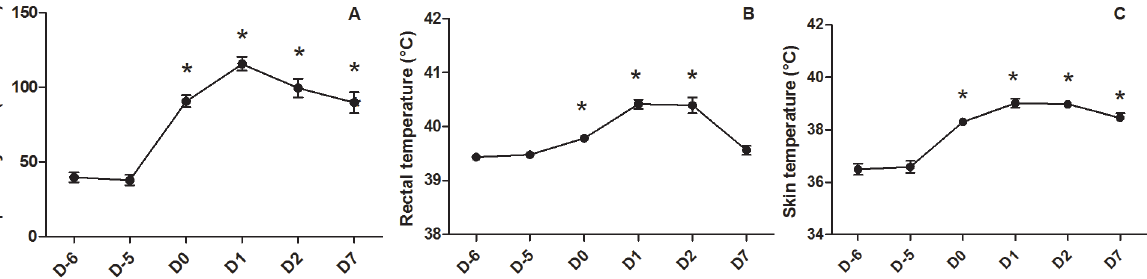
Figure 2. Effect of exposure to 32 6 C on physiological parameters in growing pigs. Mean 6 standard error. * means that daily value is significantly different ( P , 0.05) from values at 24 u C (i.e., mean of D-6 and D-5).